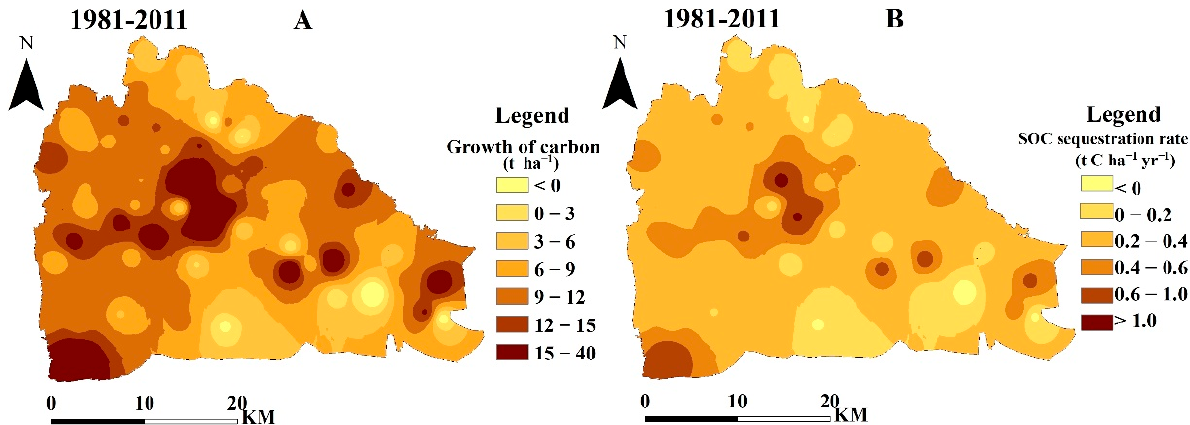
Figure 3. Distribution maps of SOCD growth ( A ) and change rate ( B ) of Fengqiu county from 1981 to 2011.